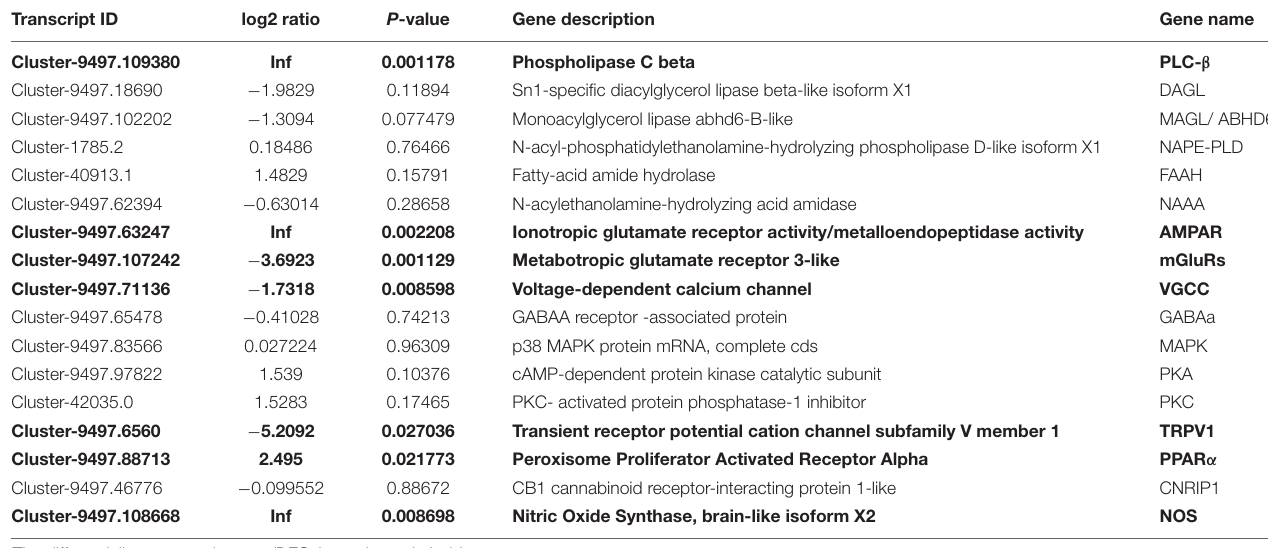
The differentially expressed genes (DEGs) are shown in bold.